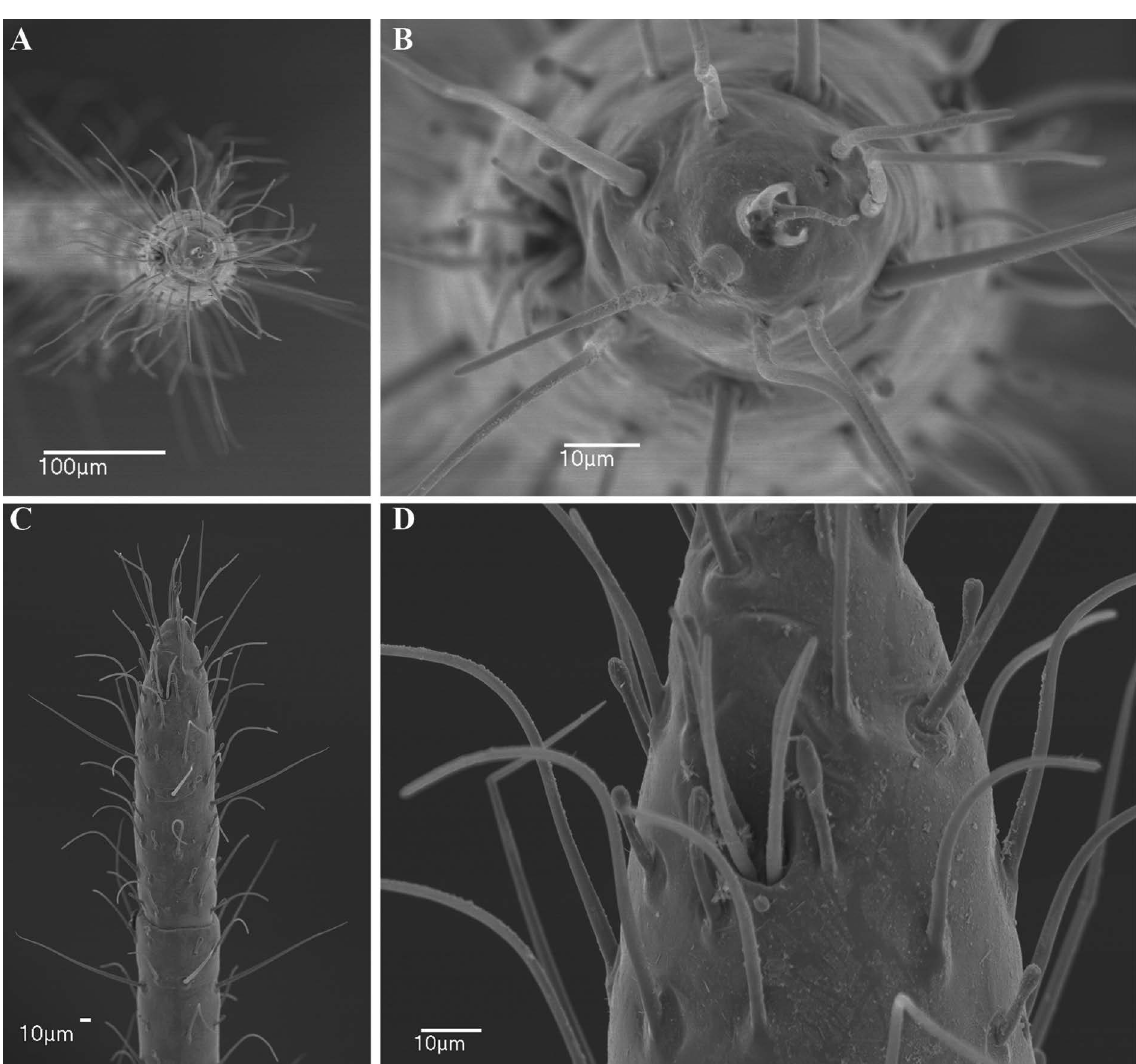
Fig. 119. Sarax palau sp. nov. (FMNH 348988), antenniform leg I, ♂. A . Apex of distal article of tarsus. B . Distal segment of tarsus, frontal view. C . Leg I showing rod sensilla and olfactory setae, ventral view. D . Rod sensilla and